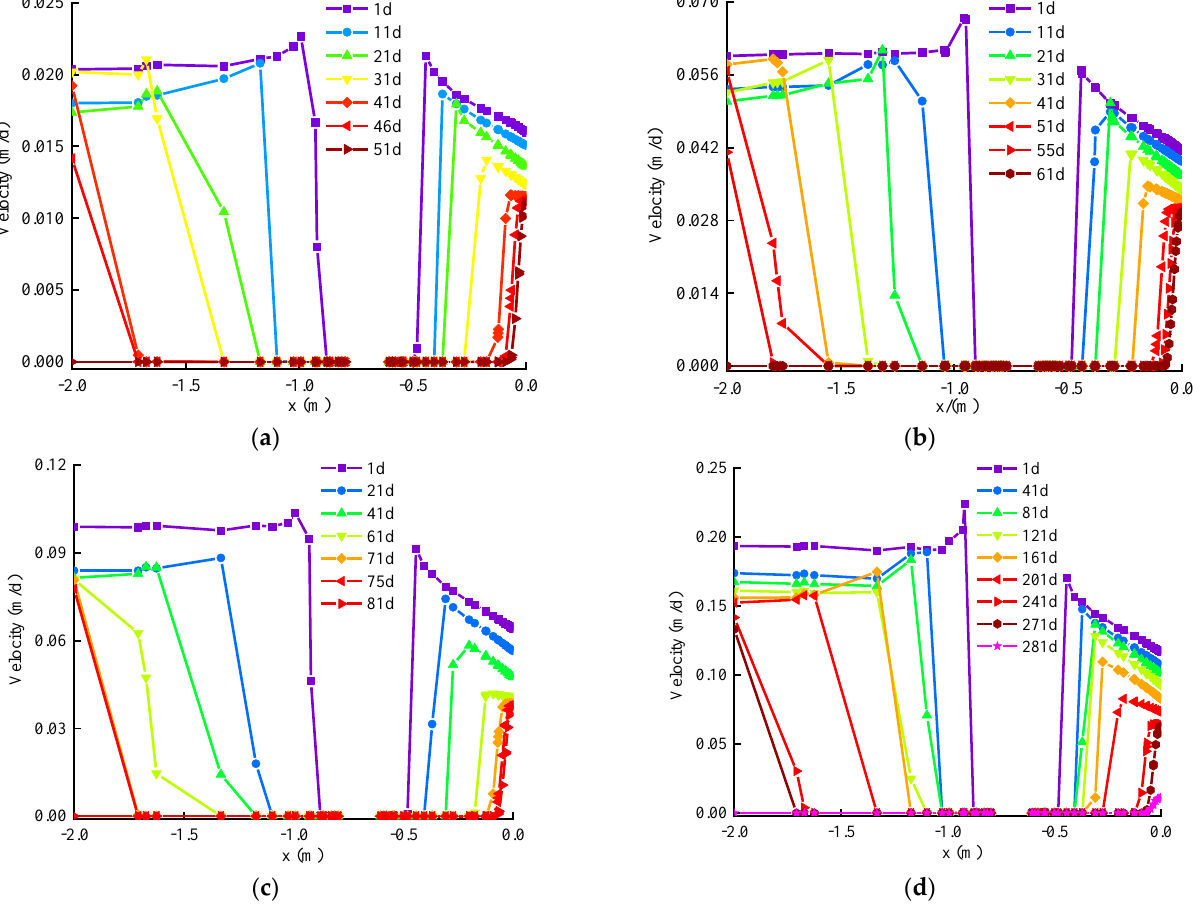
Figure 10. Variations in interfacial seepage velocity of rock in fractured rock mass with fracture aperture of5 mm during freezing, under different groundwater seepage velocities: ( a ) v = 0.1 m/d; ( b ) v = 0.3 m/d; ( c ) v = 0.5 m/d; ( d ) v = 1.0 m/d.